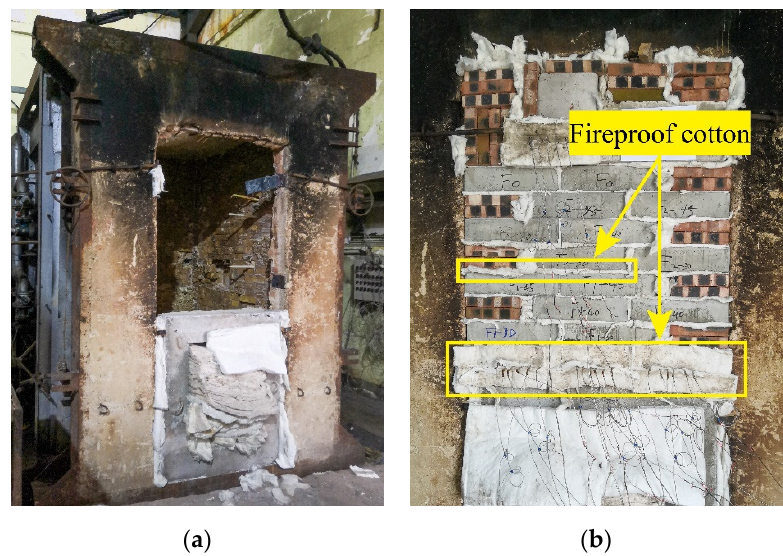
Figure 4. Furnace and fire layout: ( a ) vertical furnace; ( b ) masonry effect of the specimen. According to a decade of statistics, about 70% of urban fires burn within 60 min [52].